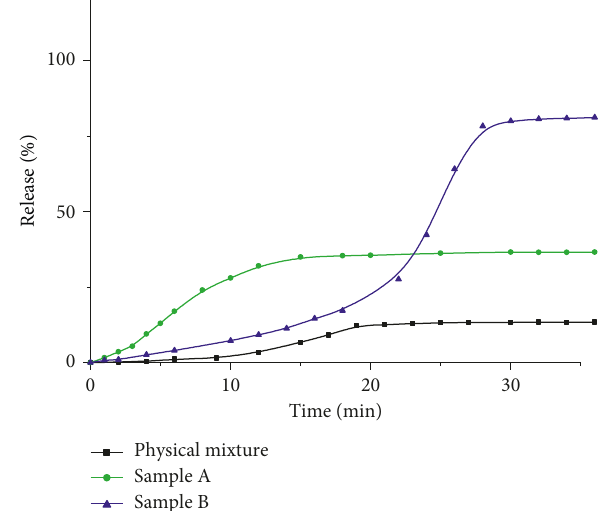
Figure 1: Release spectra of GF tablets in the two samples and physical mixture.